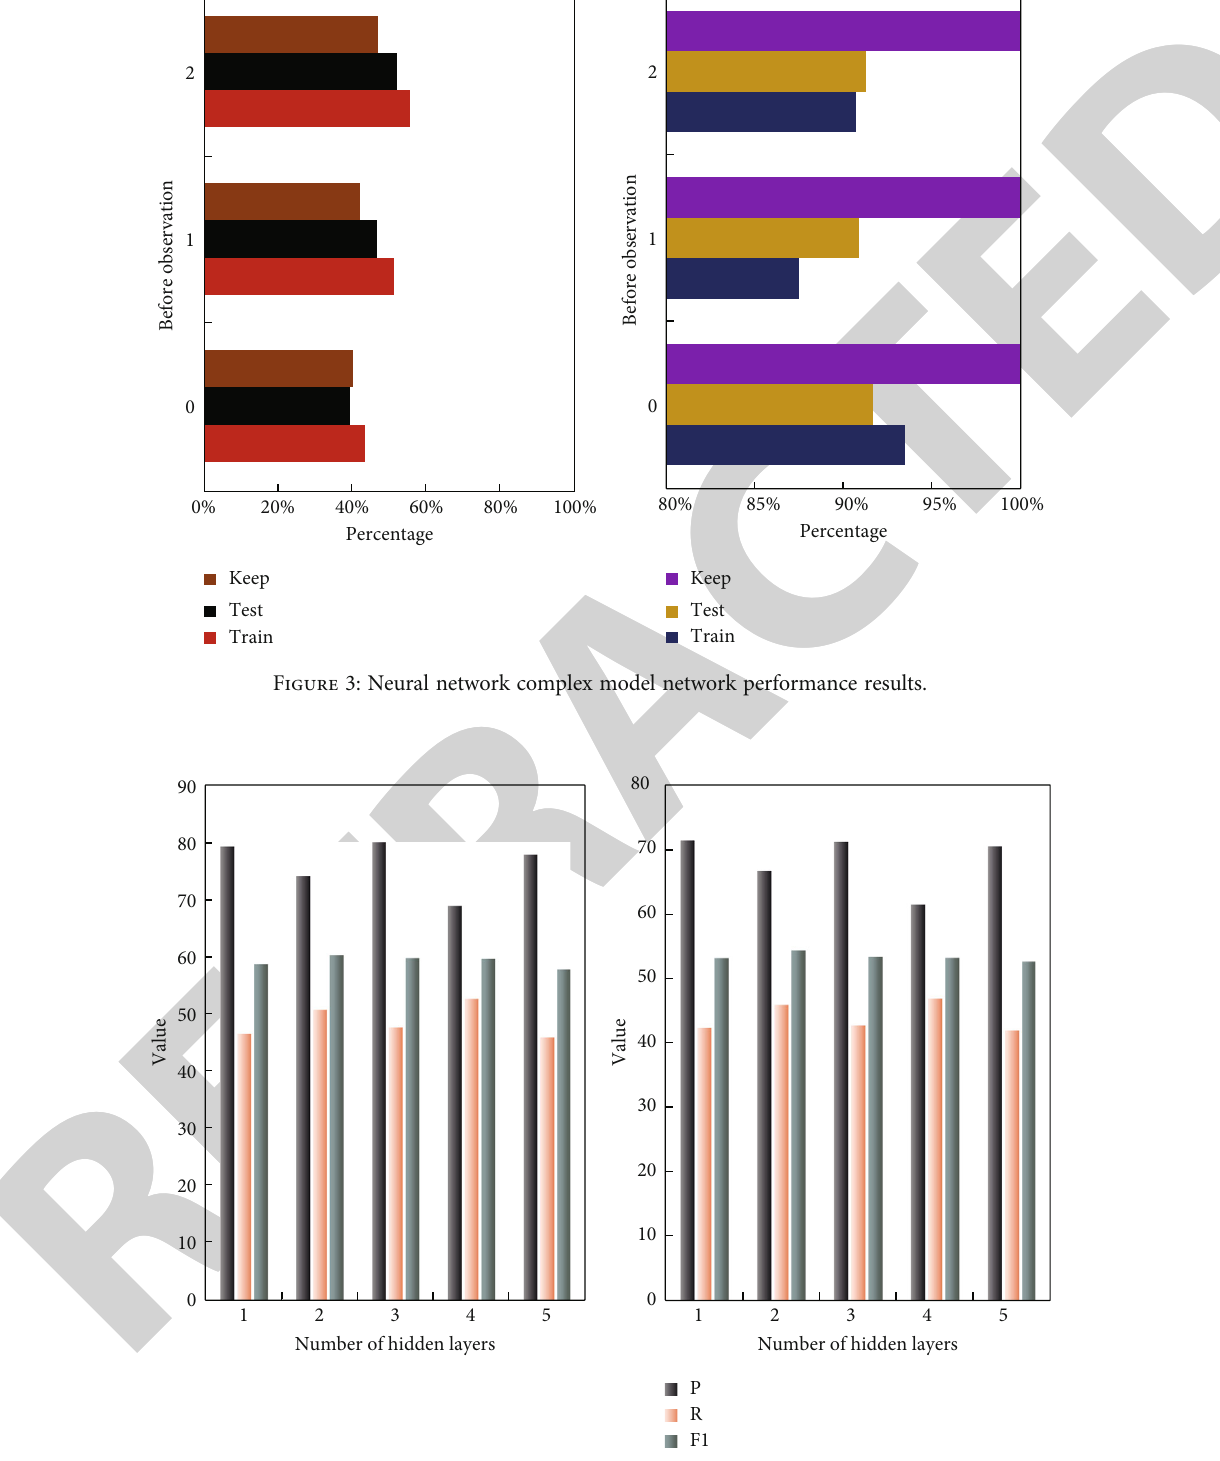
Figure 4: Neural network complex model event trigger word recognition and event type classi fi cation results.